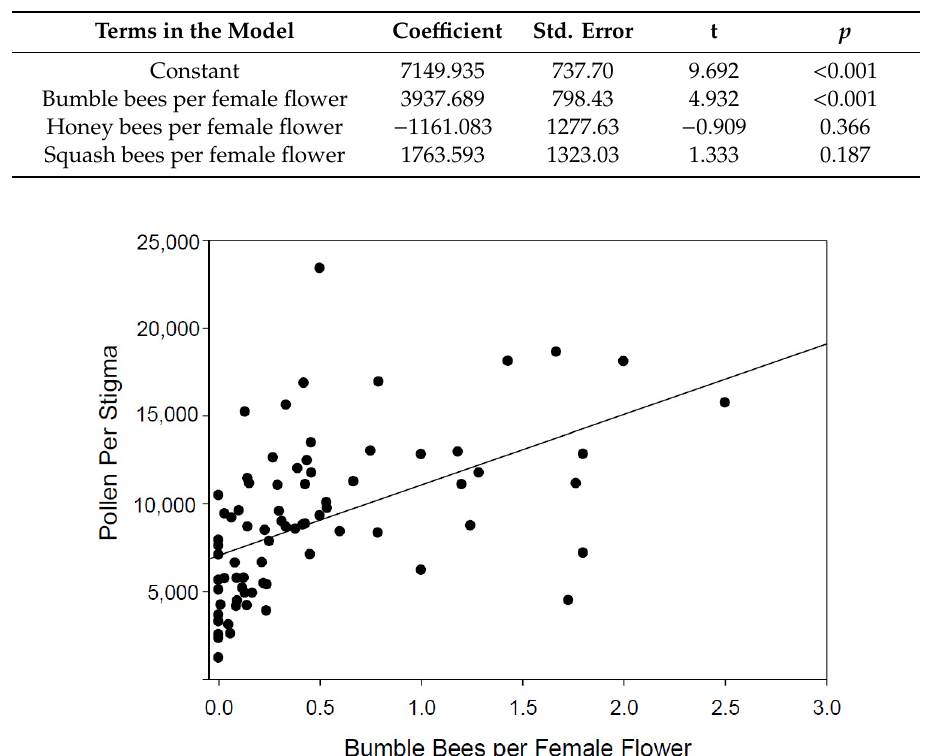
Table 3. Model parameters from multiple regression of the relationship of pollen deposition on the stigma to counts of bees on female flowers.